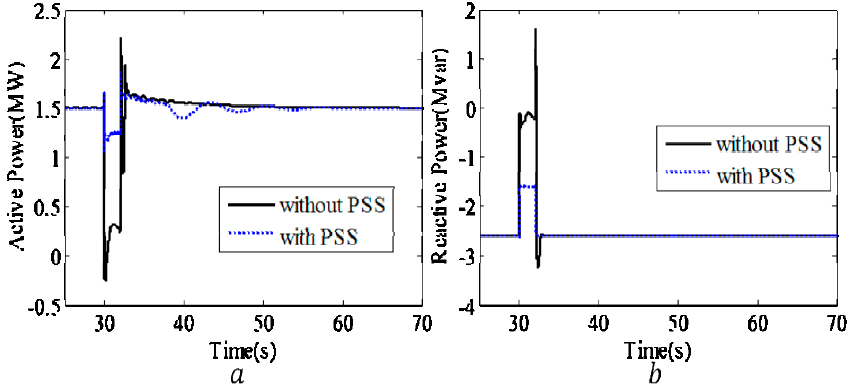
21 of 32 Figure 17 . ( a ) DC ‐ link voltage and ( b ) generator speed with PSS. 7.2. Fault Analysis with Transformation PSS The plot of the transformation PSS during the fault condition is shown below. It can be observed that the oscillations are damped even during the fault condition. This can be more clearly observed from the power plot, in which the oscillations are damped, and the settling time is also much less. From this discussion, it can be concluded that the PSS is working effectively during the fault condition.